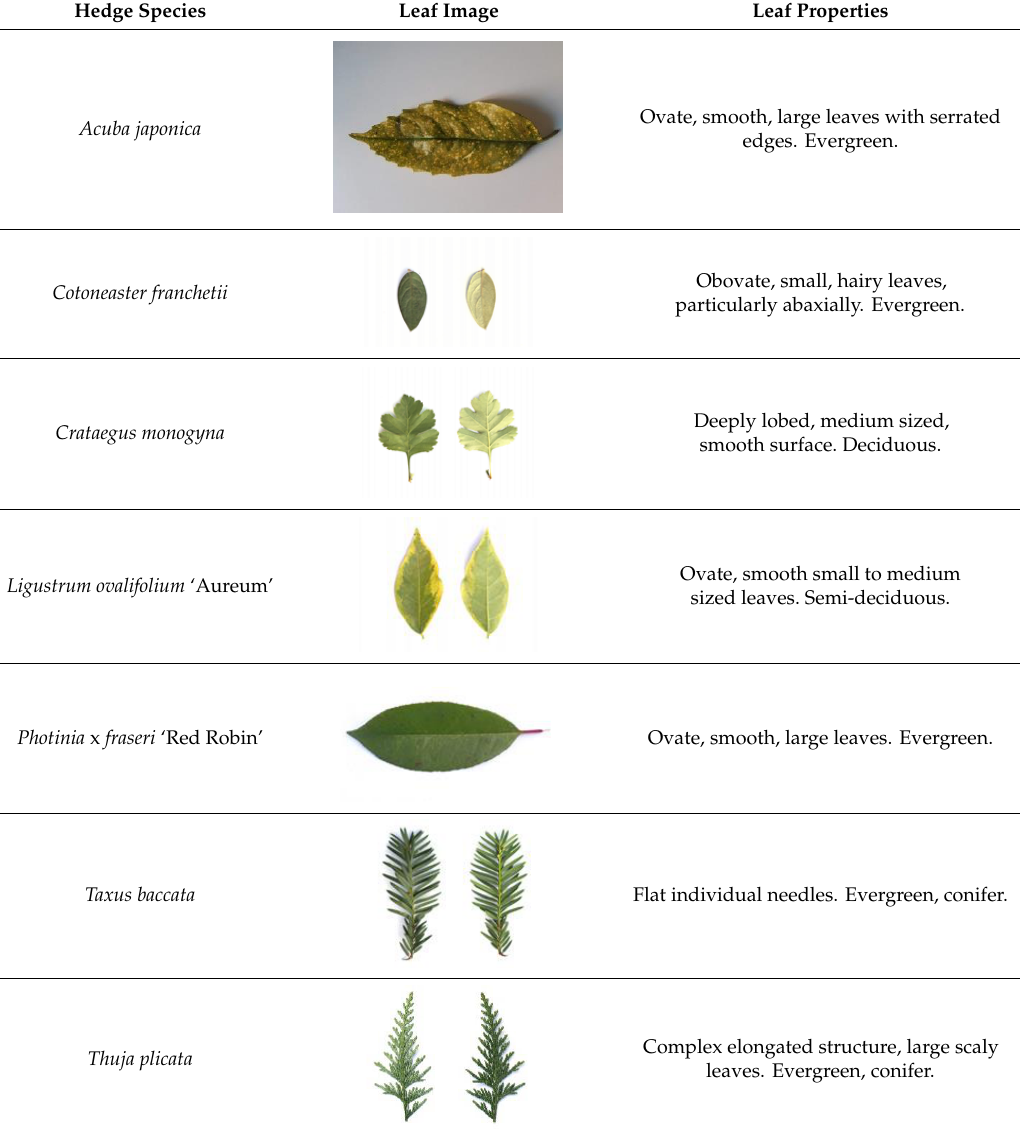
Table 2. Leaf properties of the hedge species used in the experiments.